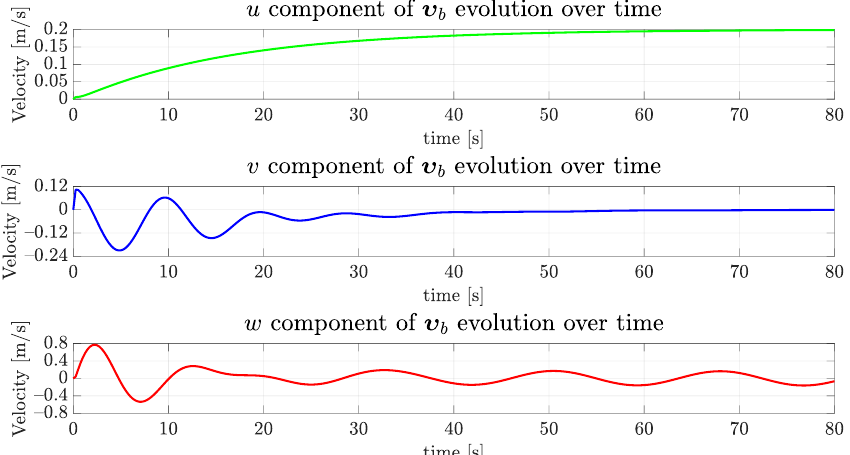
Figure 21. The evolution of the components of the simulated vehicle linear velocity over time for the sinusoidal path.